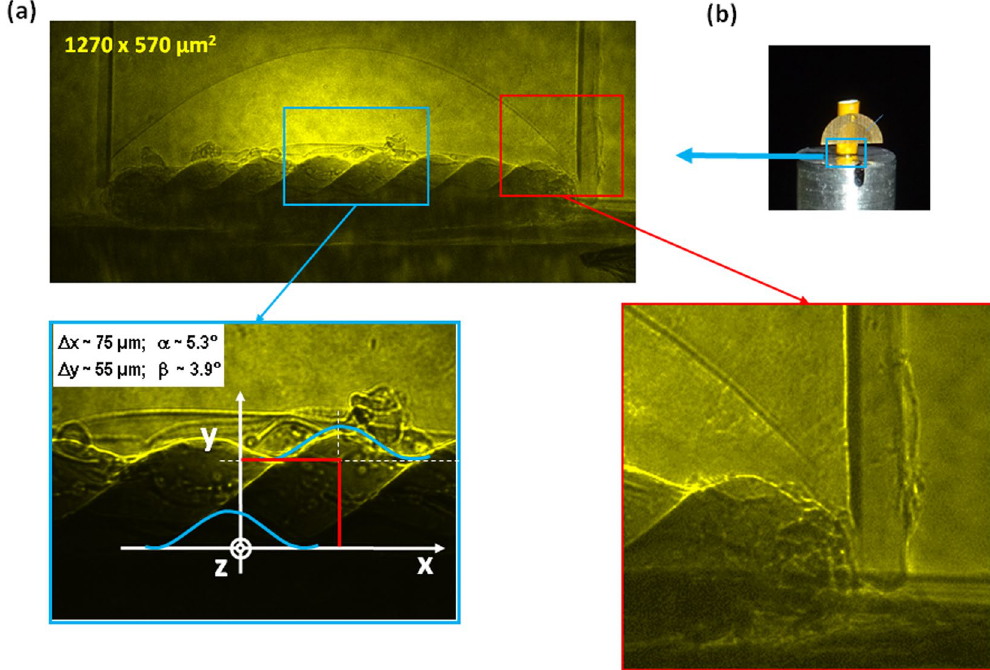
Figure 5. ( a ) Photoluminescence image of the RTI target interface obtained on a single shot of the SACLA XFEL using an LiF detector. The effect of the phase contrast enhancement is clearly seen. Two parts of the image are enlarged to better see the structural details of the target and multiple small inhomogeneities. The left hand panel shows schematically a measurement of the angular misalignment of the RTI target. Z is the axis of the XFEL beam, α and β are the angles of rotation around horizontal X and vertical Y axis, respectively. Panel (b) shows a view of the target indicating the part which is irradiated by the